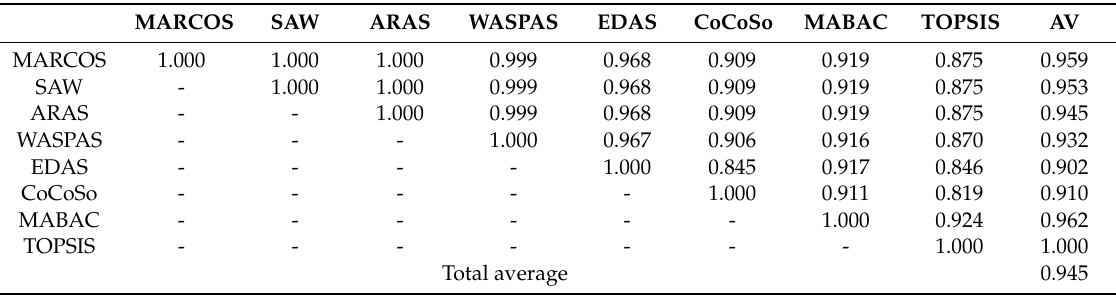
Table 6. S Statistical correlation of ranks calculated using